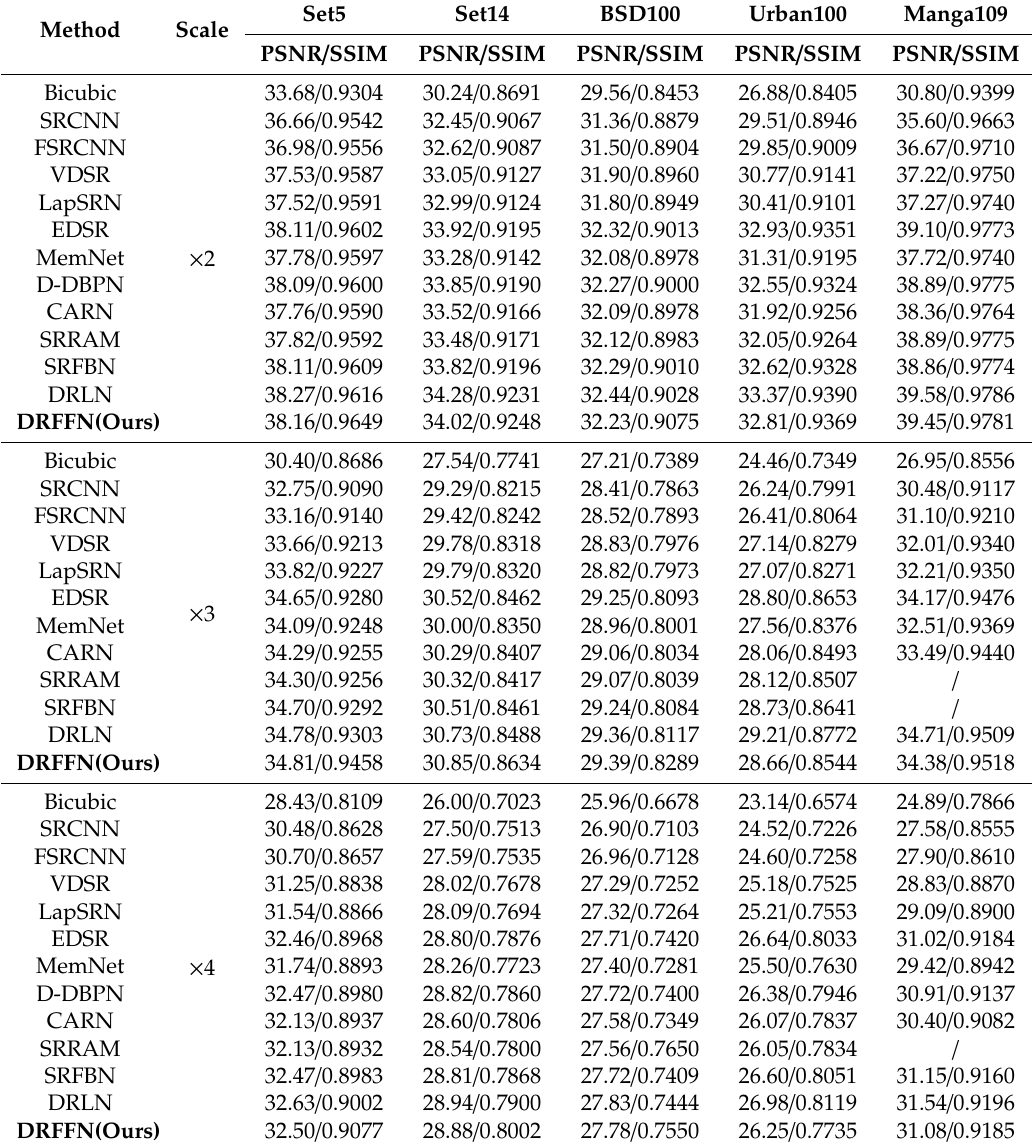
Table 2. Public benchmark datasets test results (PSNR /